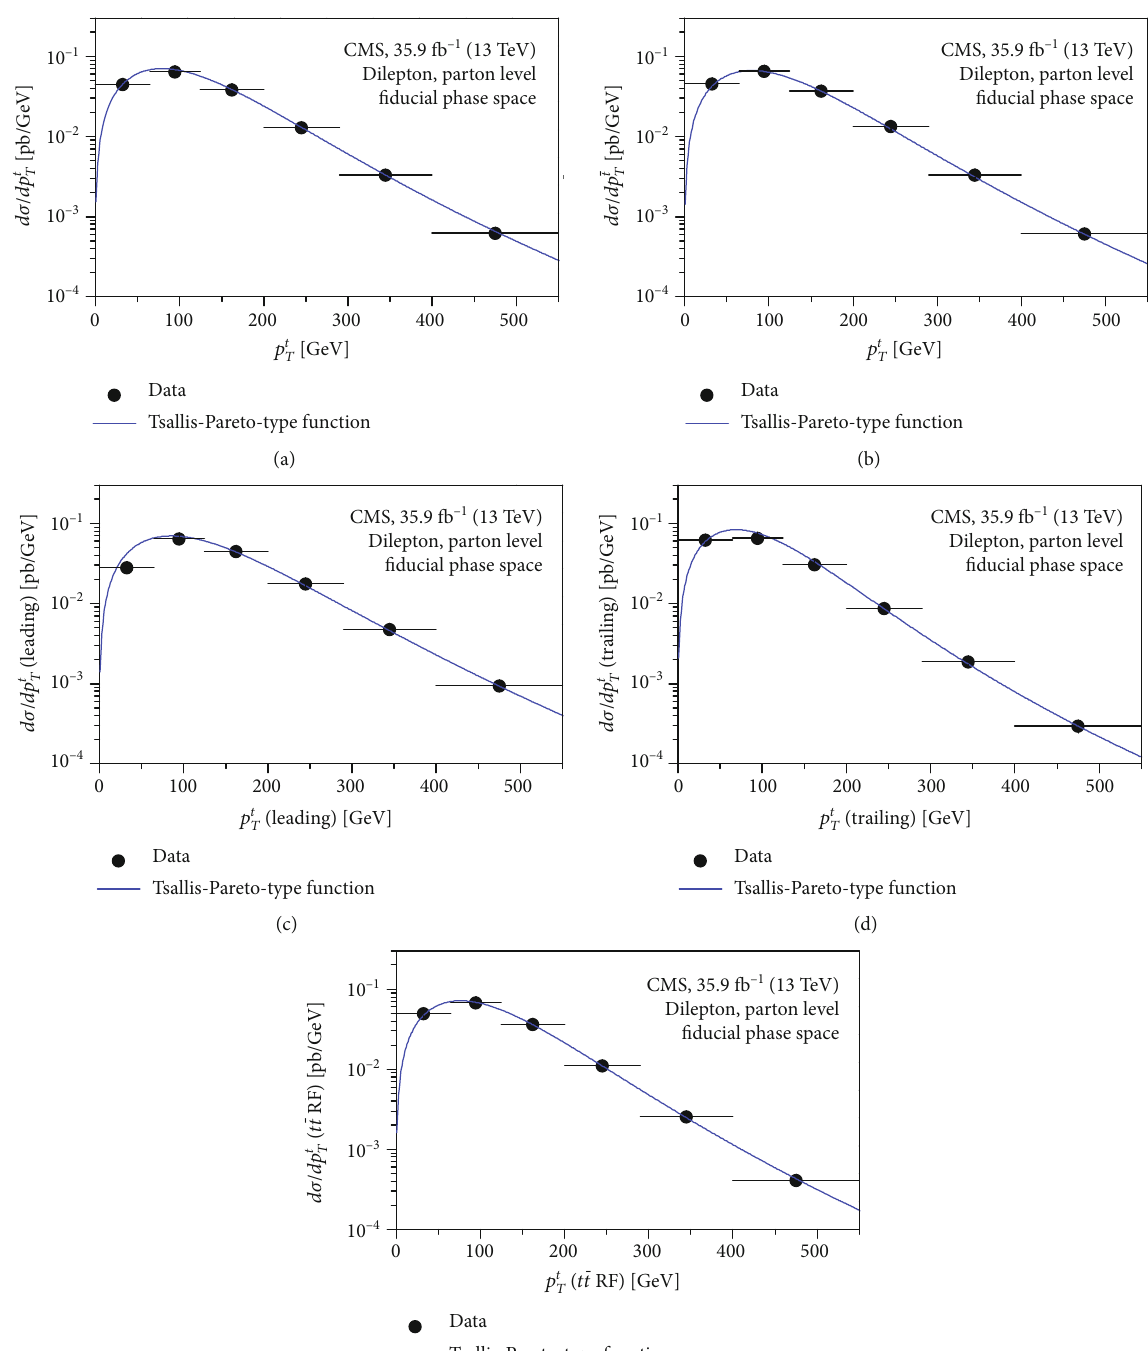
p (cid:1) t p t p t T , (b) T (leading), (d) T T , (c)